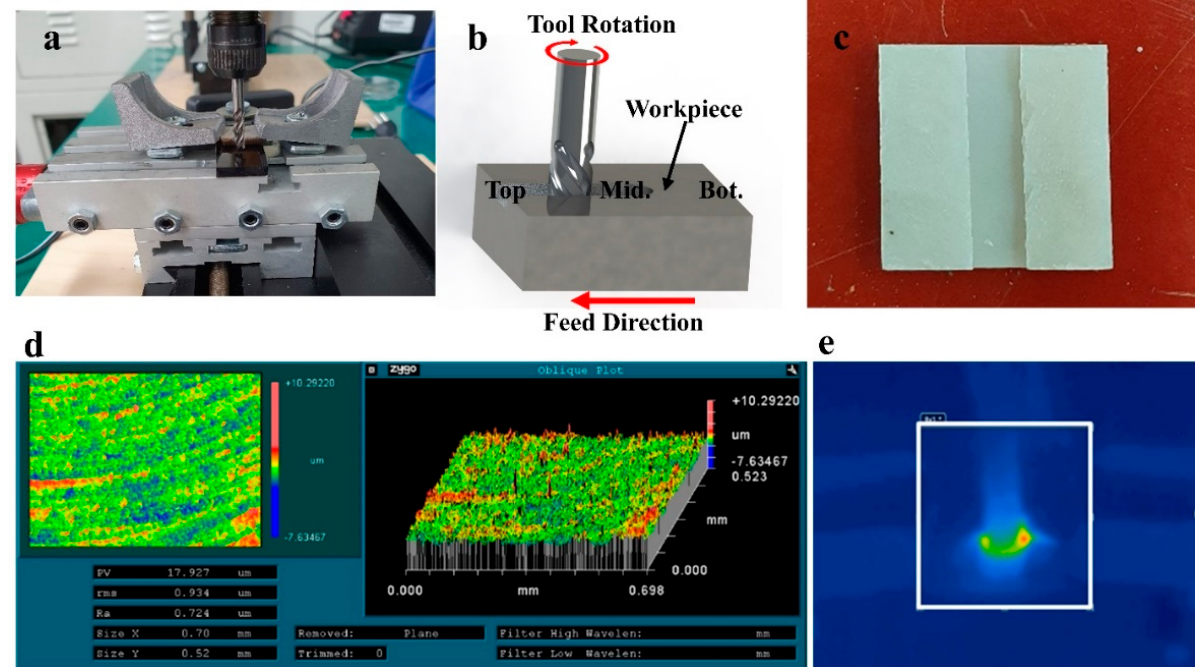
Figure 4. ( a ) Photograph of the setup for end mill machining, ( b ) schematic of the end mill machining for feed direction and machining location, ( c ) machined nanocellulose bulk material, ( d ) representative image of surface roughness, and ( e ) thermal image of machining (1.25 mm/s feed speed and 4000 rpm spindle speed).